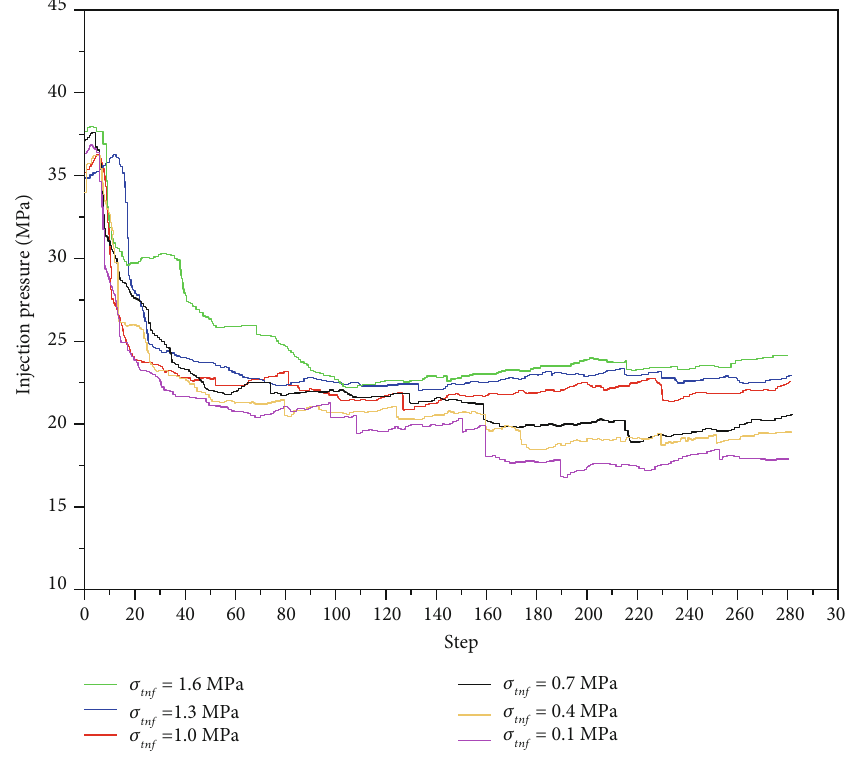
Figure 13: Injection pressure-step curves under di ff erent tensile strength of CCFs.